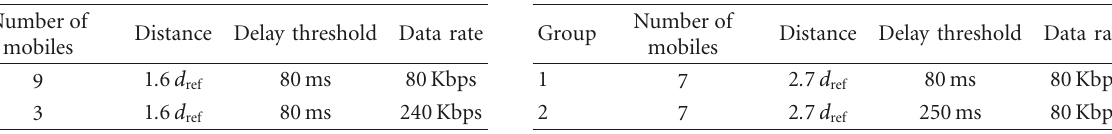
Table 2: Second scenario setup. Table 3: Third scenario